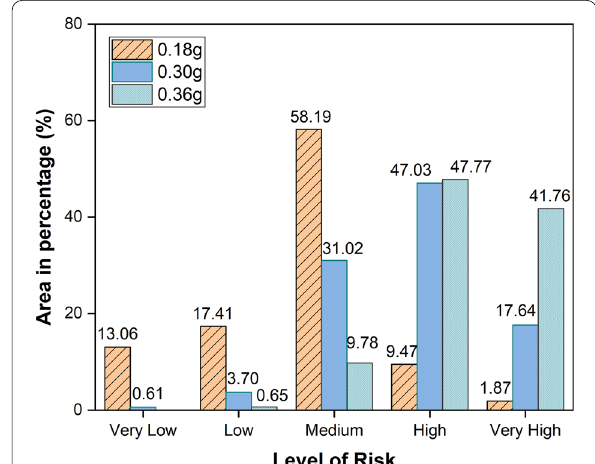
Fig. 14 Area in percentage of the level of risks based on probability of ground failure ( P G ) in three scenario earthquakes of M w 7.8 (0.18